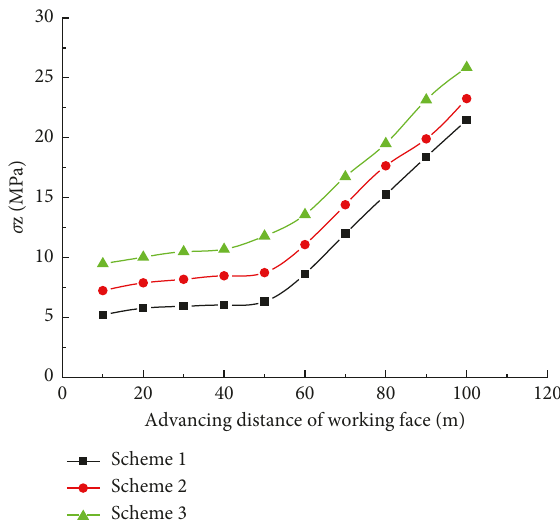
Figure 13: Vertical stress in protective coal